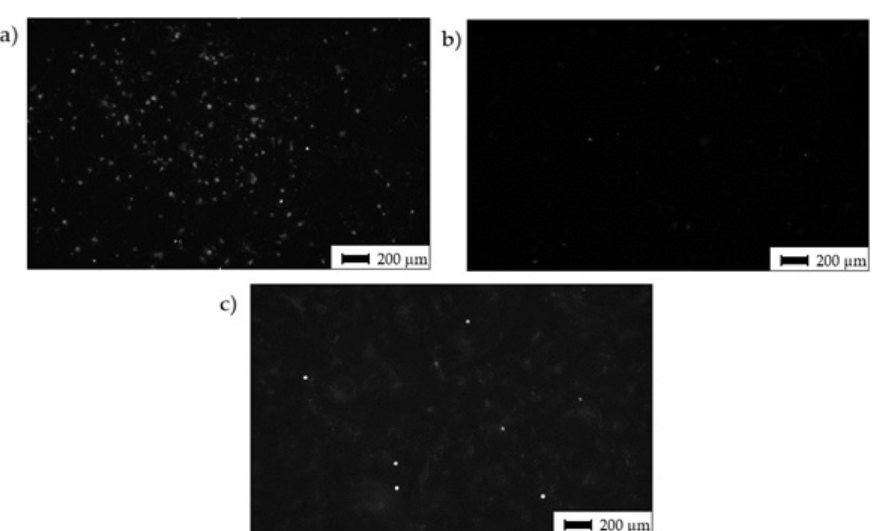
Figure 10. Osteo-differentiation of hMSCs—black and white images of hMSCs cultivated for 14 days in osteo-differentiation medium. Staining of antibody against osteo-marker osteocalcin; ( a ) Surface A; ( b ) Surface B; ( c ) surface of the control sample (CTRL—PS).